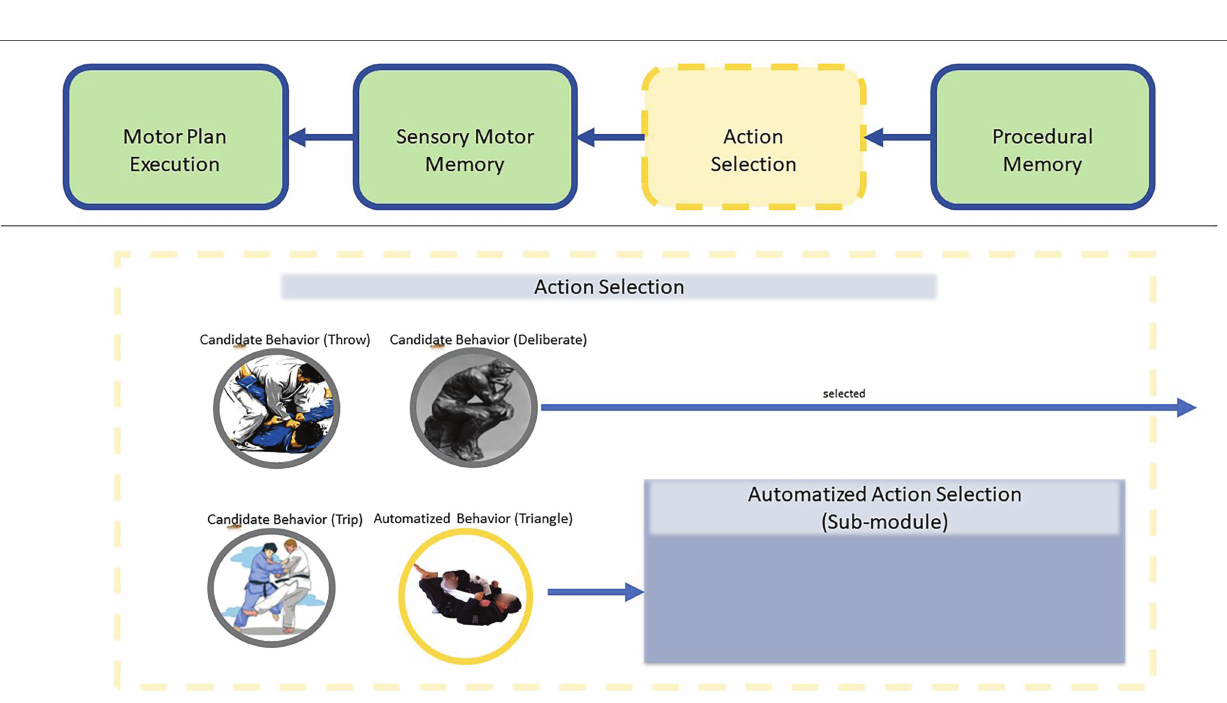
FIGURE 6 | Here, we are zooming into Action Selection. In this case, Action Selection is choosing between a wealth of candidate behaviors. In this case, Action Selection chooses the “triangle choke” and passes it on to the Automatized Action Selection sub-module. Action Selection and the Automatized Action Selection sub-module run in parallel to facilitate multitasking. In this case, the agent is choosing to perform a Triangle choke while simultaneously choosing to “deliberate” on what to do